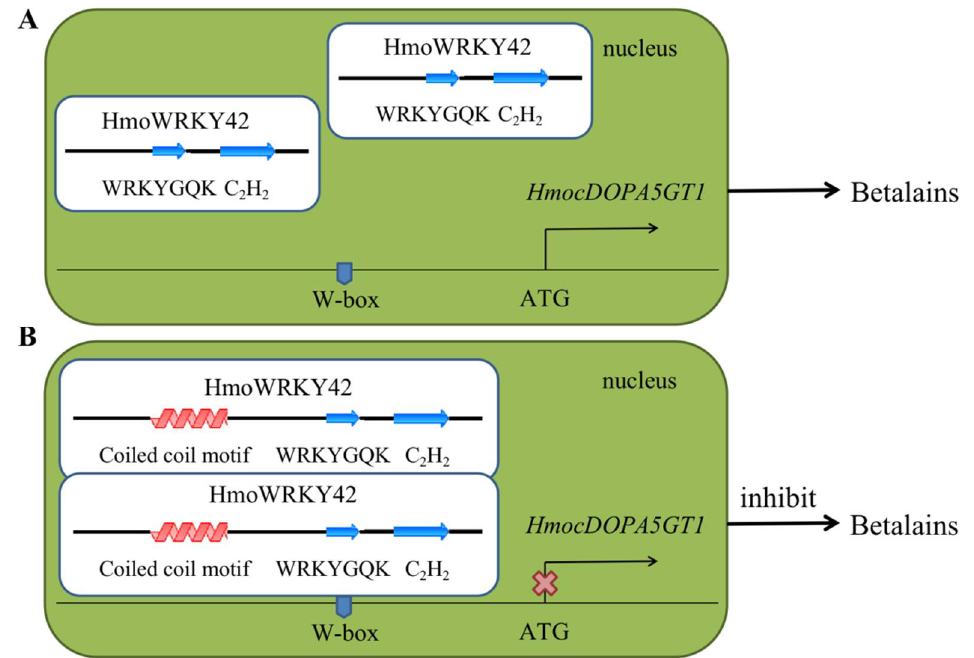
Figure 10. The regulatory model of HmoWRKY42 involved in betalain biosynthesis of pitayas. ( A ) Knocking out the coiled-coil motif of HmoWRKY42 prevented its self-interaction and prevented it from binding to the HmocDOPA5GT1 promoter. ( B ) The coiled-coil motif, the WRKY domain and the C 2 H 2 zinc finger motif are key motifs for the binding of HmoWRKY42 to the HmocDOPA5GT1 promoter.